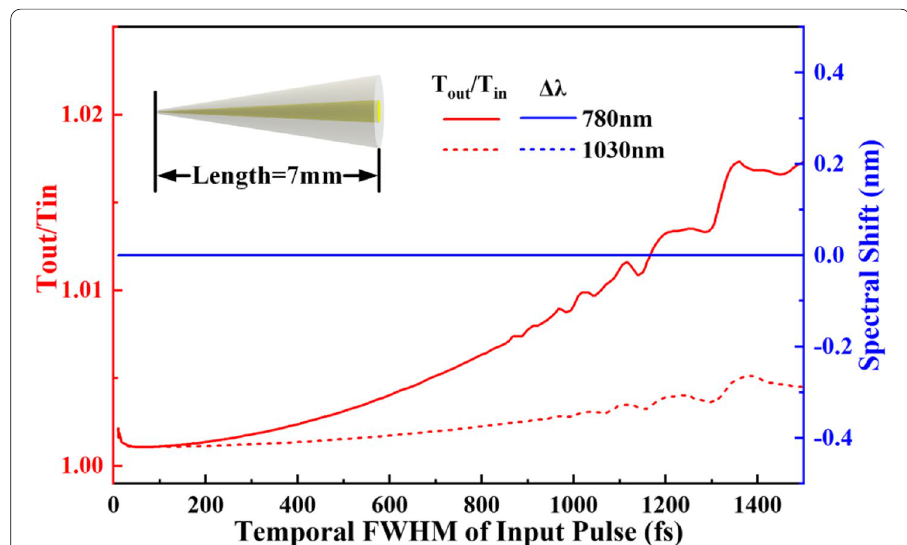
Fig.6 The calculated time domain broadening and the spectral shift of ultrashort pulses with different pulse widths transmitted by a 7 mm tapered optical fiber probe. The total time domain broadening ratio is < 1.02 for 780 nm pulses and < 1.005 for 1030 nm pulses